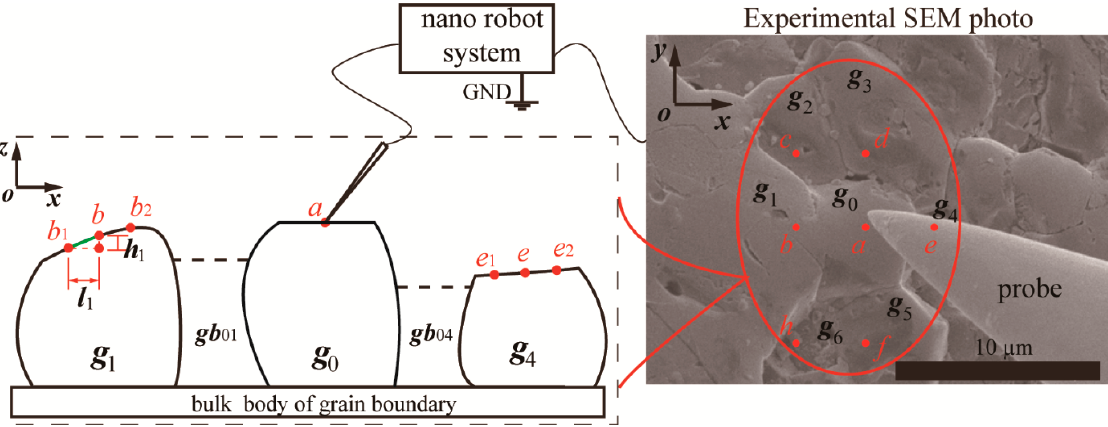
Figure 1. Schematic diagram accounting for three-dimensional characterization of nonlinear structure lengths of micro-area grain boundary interfaces in bulk ZnO ceramics.